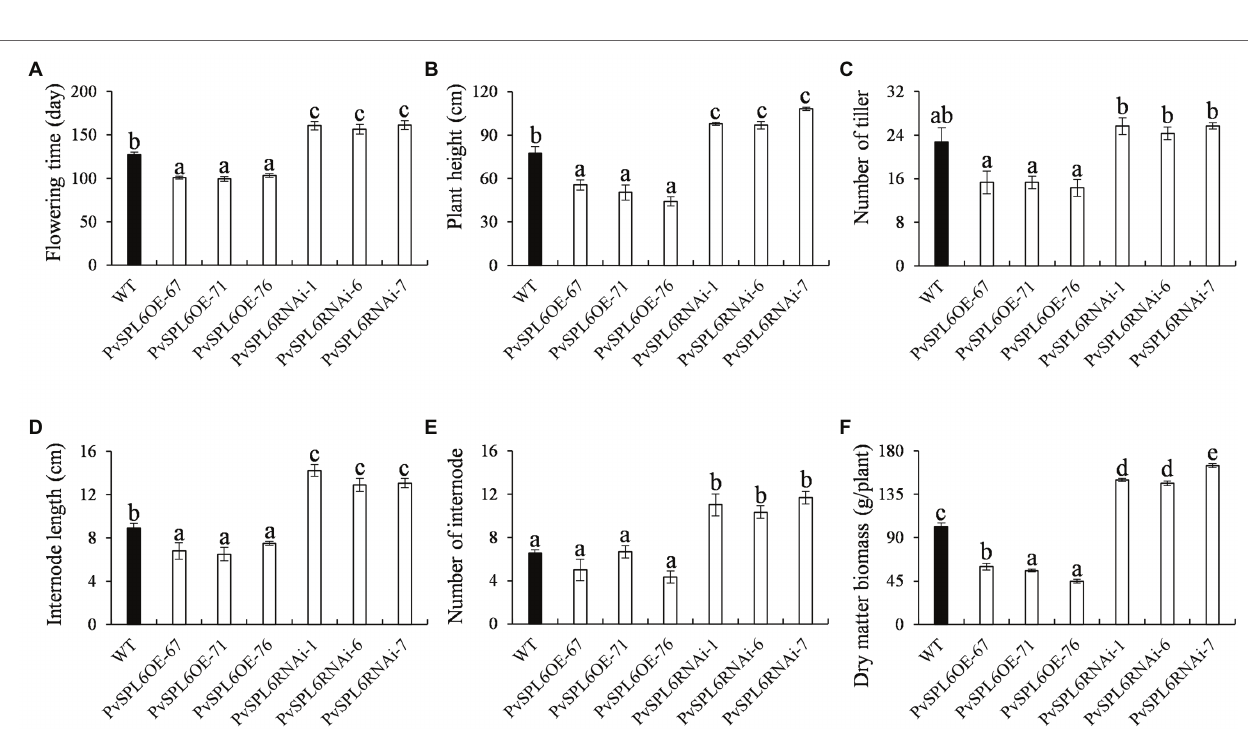
FIGURE 4 | Quantitative real-time PCR (qRT-PCR) analysis of PvSPL6 transcript levels in different PvSPL6 OE and PvSPL6 RNAi transgenic switchgrass plants. (A) qRT-PCR analysis of PvSPL6 transcript levels in different PvSPL6 OE transgenic switchgrass plants. (B) Quantitative real-time PCR analysis of PvSPL6 transcript levels in different PvSPL6 RNAi transgenic switchgrass plants. PvUBQ2 was used as a reference for normalization. The values are the means ± SEs ( n = 3). The letters above the error bars indicate significant differences determined by one-way ANOVA ( p < 0.05, Duncan’s multiple-range test).